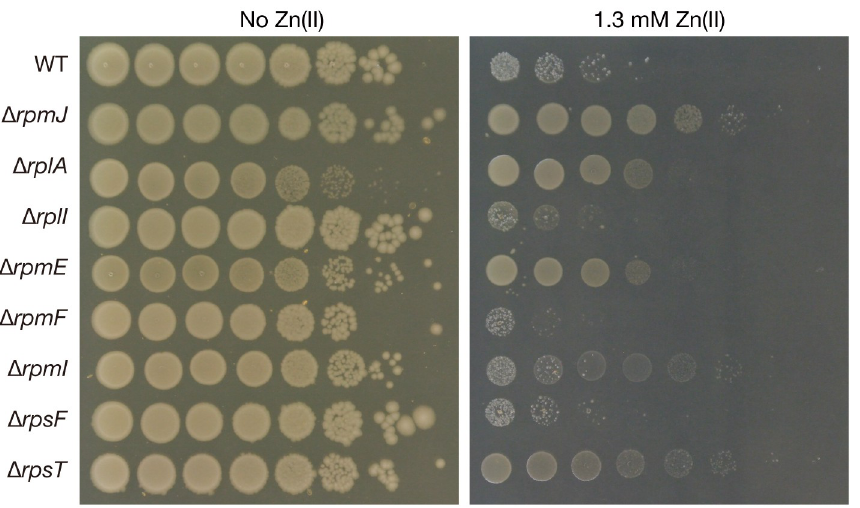
Fig 7. Knockout mutants of nonessential ribosomal proteins exhibit zinc resistance. Overnight cultures of the wild- type strain and knockout mutants of ribosomal proteins (RpmJ, RplA, RplI, RpmE, RpmF, RpmI, RpsF, and RpsT) were serially diluted 10-fold, spotted onto LB agar plates with or without 1.3 mM Zn(II), and incubated overnight at 37˚C.